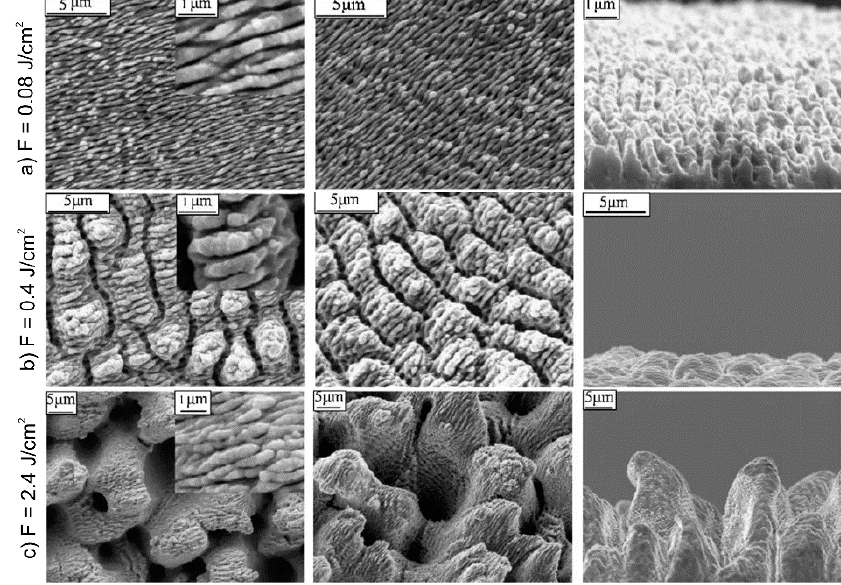
Figure 5. SEM micrographs of top, side (30°) and profile view of stainless steel surfaces at various laser fluence: ( a ) F = 0.08 J/cm 2 ; ( b ) F = 0.4 J/cm 2 ; and ( c ) F = 2.4 J/cm 2 . Reprinted from Wu et al . [51], Copyright 2009, with permission from Elsevier.